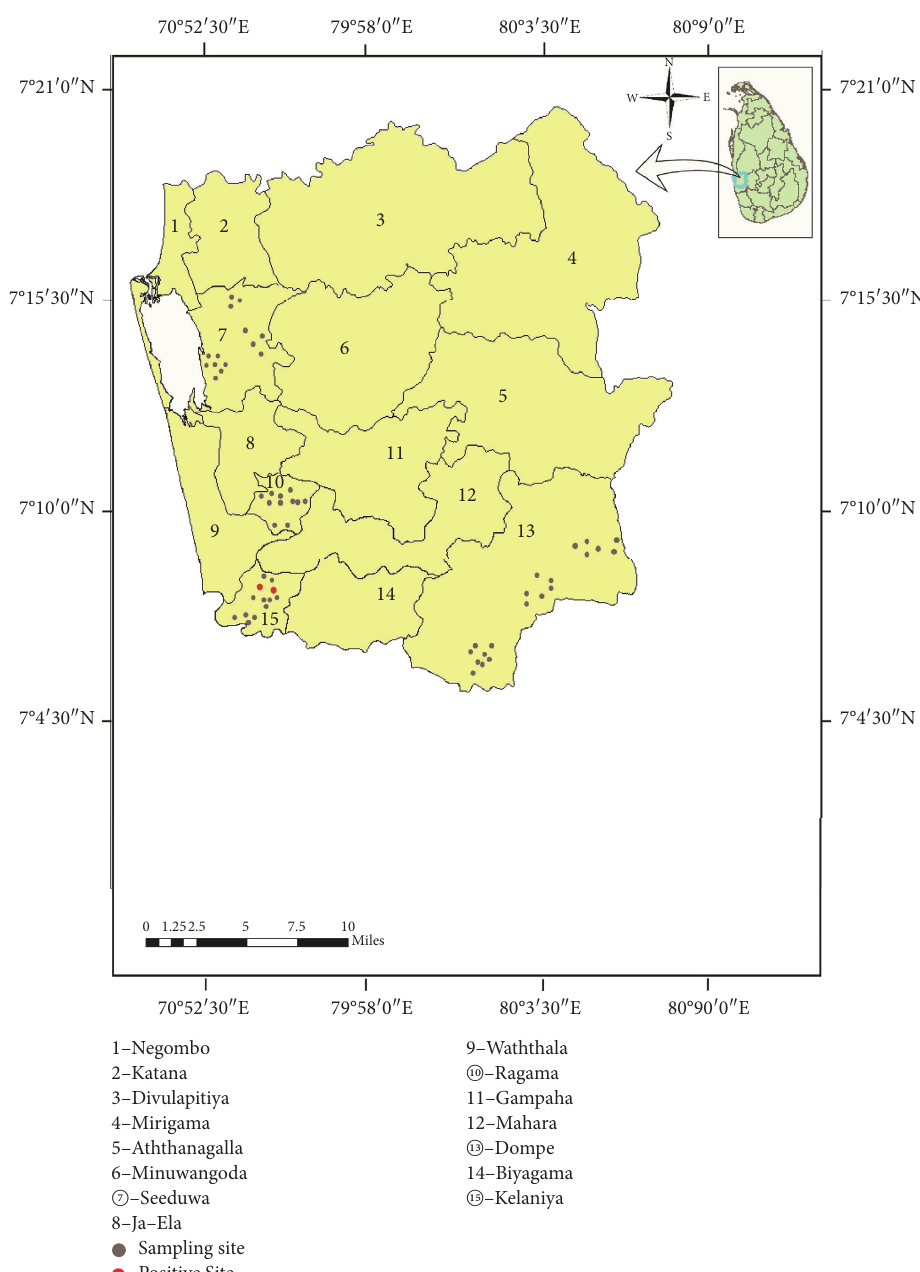
Figure 1: Map showing the selected MOH areas, sampling sites and positive sites for filariassis parasites in the Gampaha